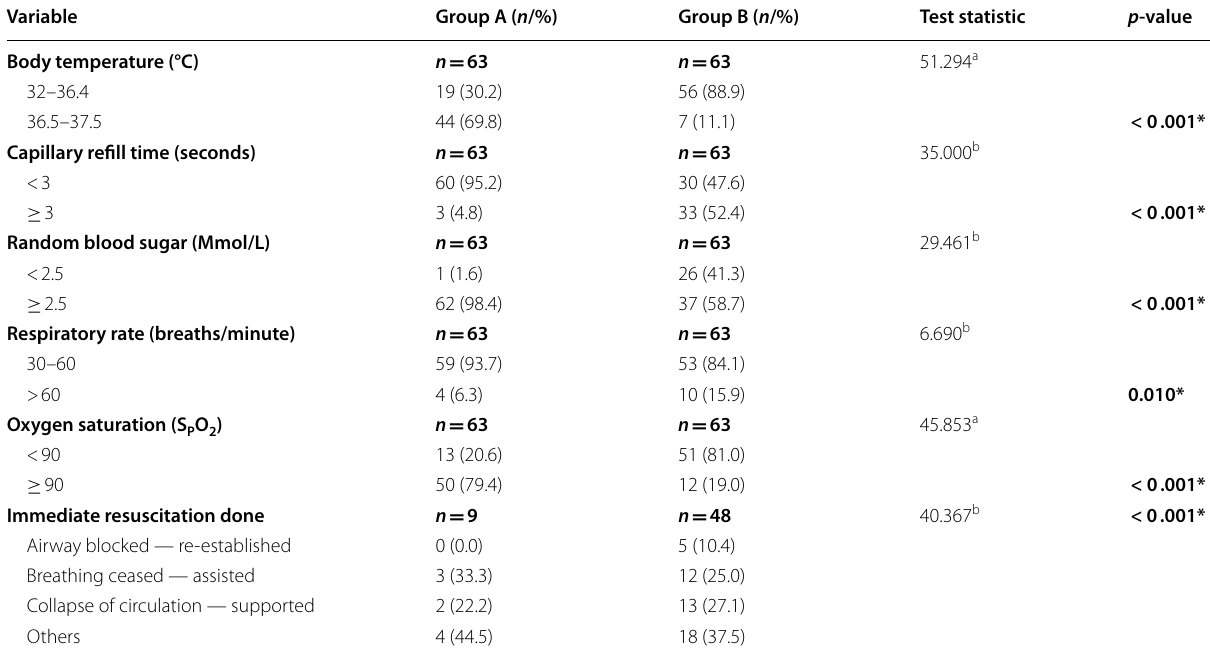
Table 3 Distribution of newborns according to parameters indicating their clinical status at